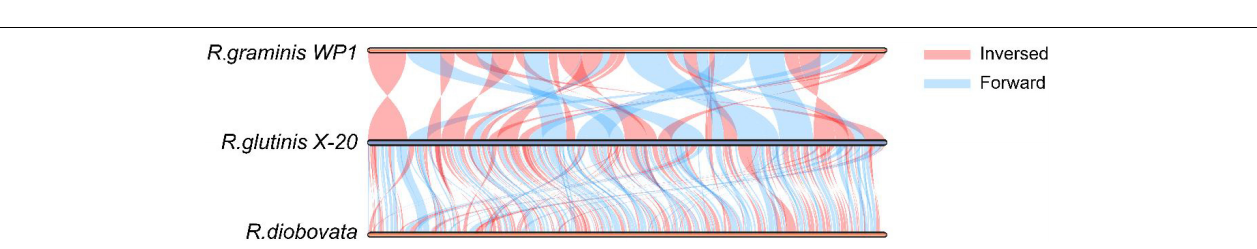
FIGURE 2 | Phylogenetic and evolutionary analysis between 25 strains of red yeasts of the order Sporidiobolales . The phylogenetic tree was built in MEGA 7.0 using an alignment of the 18S rDNA sequences, the Neighbor-joining technique, and a Bootstrap analysis of 1,000 iterations. An asterisk denotes the strain R. glutinis X-20 and its closely related species. The bootstrap value is shown by the number at each branch of the phylogenetic tree (1,000 replicates). Shades of blue, purple, and yellow represent the various clusters of Rhodosporidiobolus , Sporobolomyces , and Rhodotorula isolates, respectively.